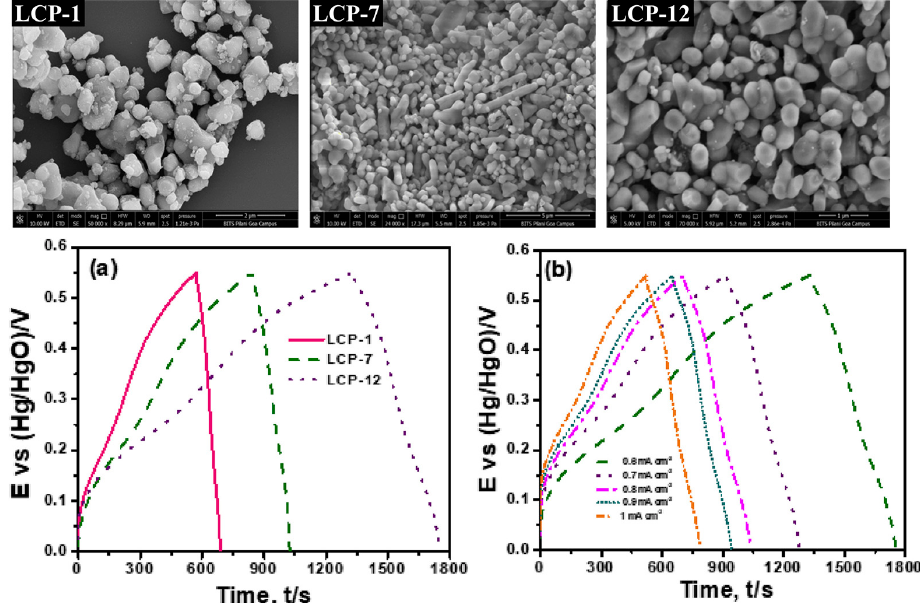
Figure 1. FE-SEM images of LCP-1, LCP-7, LCP-12; ( a , b ) galvanostatic charge-discharge capacitance Figure 1. FE ‐ SEM images of LCP ‐ 1, LCP ‐ 7, LCP ‐ 12; ( a , b ) galvanostatic charge ‐ discharge capacitance comparison. LCP-1 fabricated from the solution with the pH = 1; LCP-7 fabricated from the solution comparison. LCP ‐ 1 fabricated from the solution with the pH = 1; LCP ‐ 7 fabricated from the solution with the pH = 7; LCP-12 fabricated from the solution with the pH = 12) with the pH = 7; LCP ‐ 12 fabricated from the solution with the pH = 12) [29].